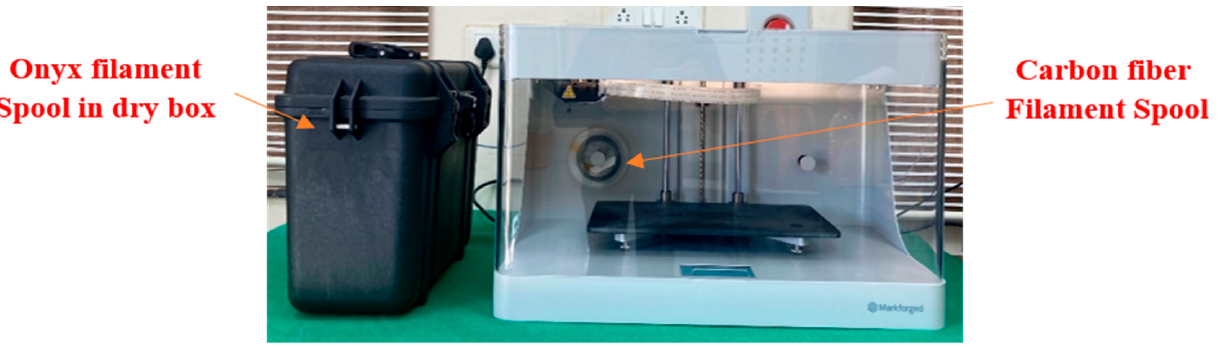
Figure 1. Mark Two 3D printer.